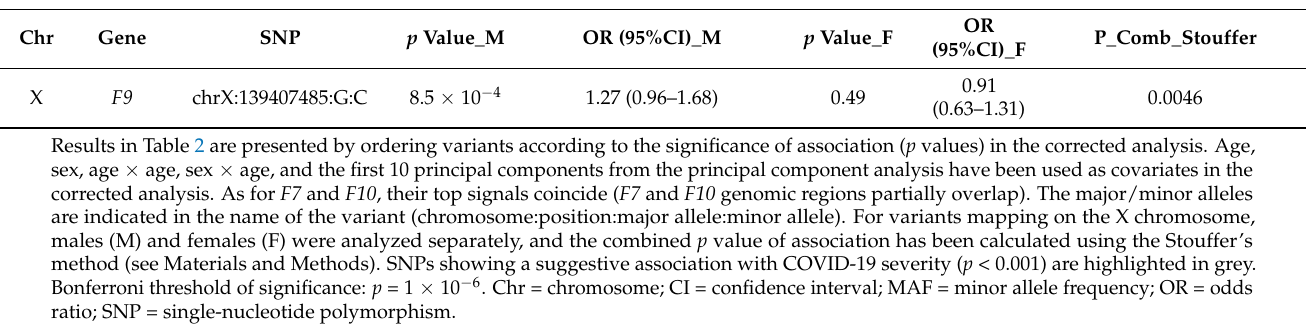
Table 3. Association results for functional SNPs in F5 , F2 , and F13A1 .